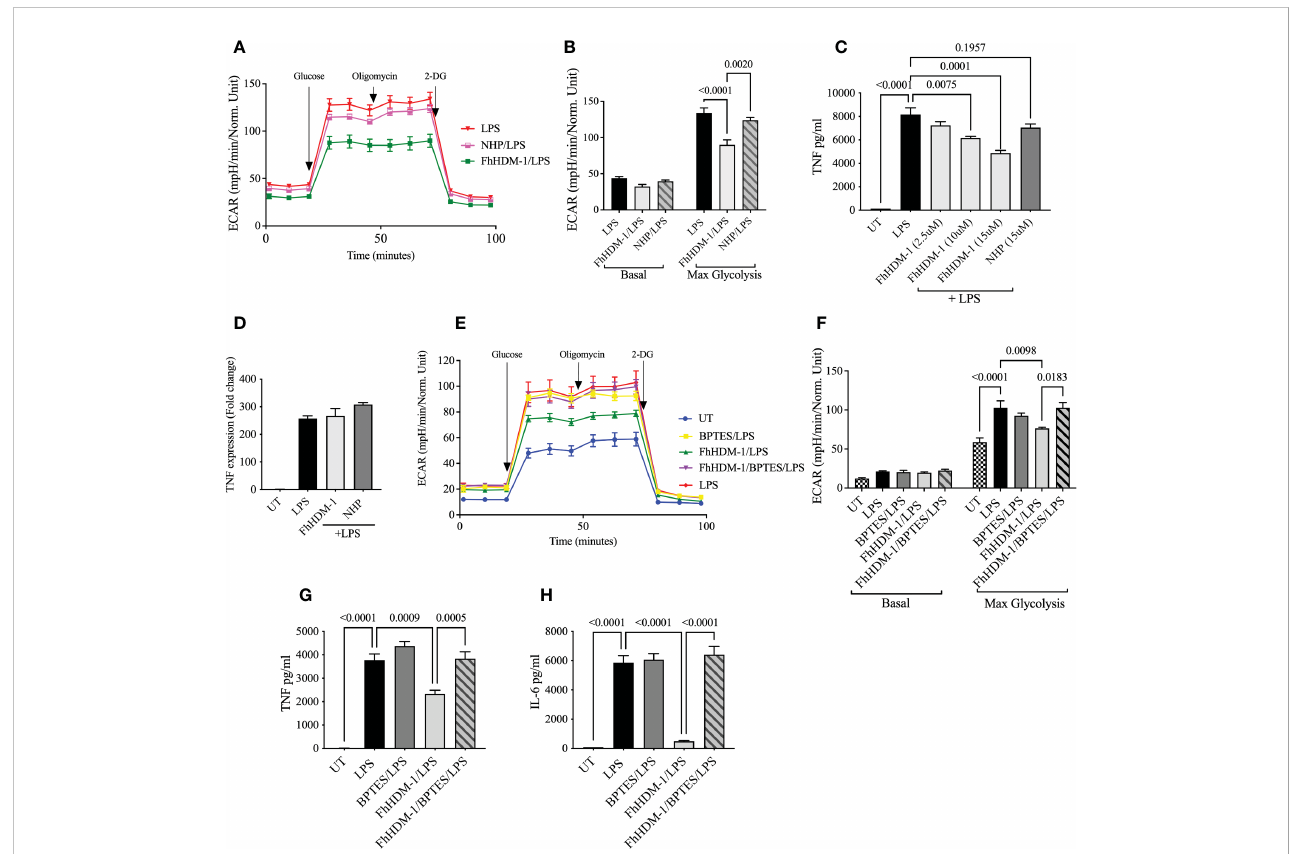
FIGURE 4 FhHDM-1 induced glutaminolysis mediates a reduced in fl ammatory response and decreased glycolysis, (A) BMDMs were treated 20ng/mL LPS or a combination of FhHDM-1 (2.5µM) or NHP (2.5µM), and LPS for 24h (n=4). Then glycolytic activity was determined by measuring the extracellular acidi fi cation rate (ECAR) and (B) maximum glycolytic activity as cells were treated with glucose, oligomycin and 2-deoxy-glucose (2-DG). (C, D) Macrophages derived from the bone marrow of C57BL/6 mice were either untreated (UT) or cultured for 1h with FhHDM-1 (2.5µM, 10µM and 15µM) or NHP (15µM), and then washed and stimulated with 20ng/ml LPS (n=3). (C) The levels of TNF secreted after an overnight incubation were quanti fi ed by ELISA, and (D) the levels of TNF gene expression at 6h after LPS treatment were determined by qRT-PCR. (E) BMDMs were either untreated (UT) or treated with LPS (20ng/mL), the glutamate inhibitor BPTES (10µM)/LPS, FhHDM-1 (2.5µM)/LPS or FhHDM-1/BPTES/LPS for 18h (n=4). The glycolytic activity was determined by measuring the extracellular acidi fi cation rate (ECAR) and (F) the maximum glycolytic capacity of cells after